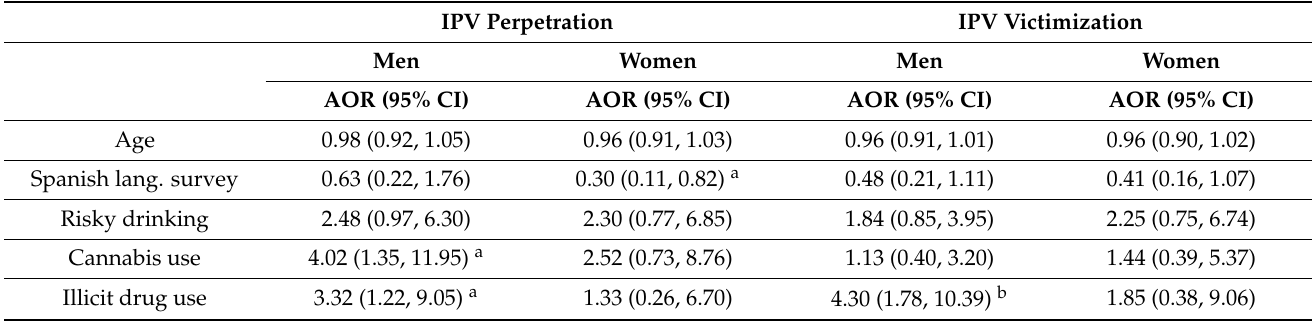
Table 4. Associations between substance use and intimate partner